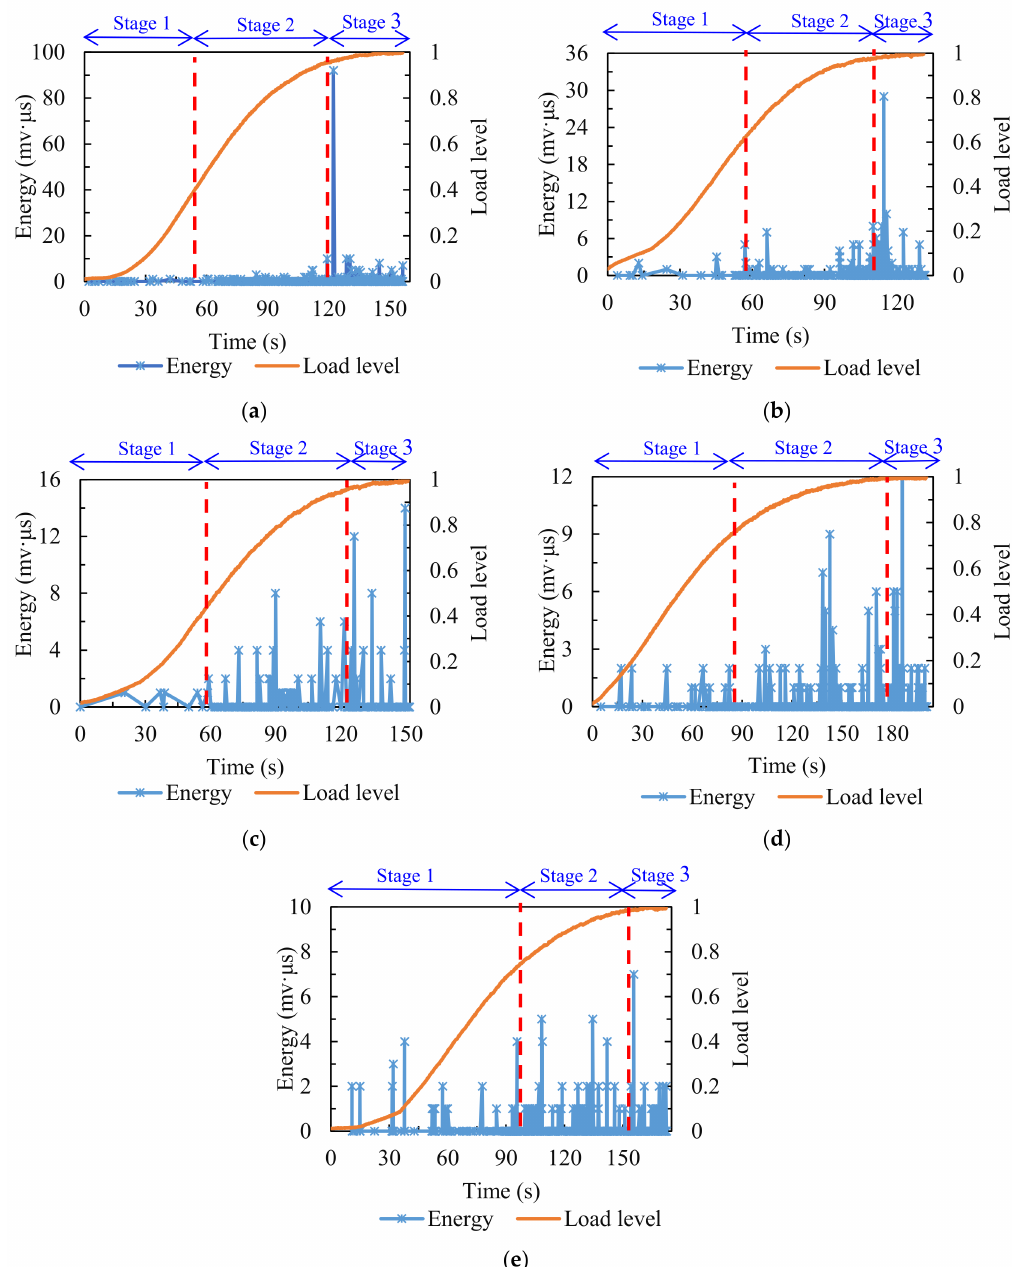
Figure 5. Energy distribution of specimens treated with various numbers of F–T cycles: ( a ) 0; ( b ) 1; ( c ) 3; ( d ) 5; ( e )